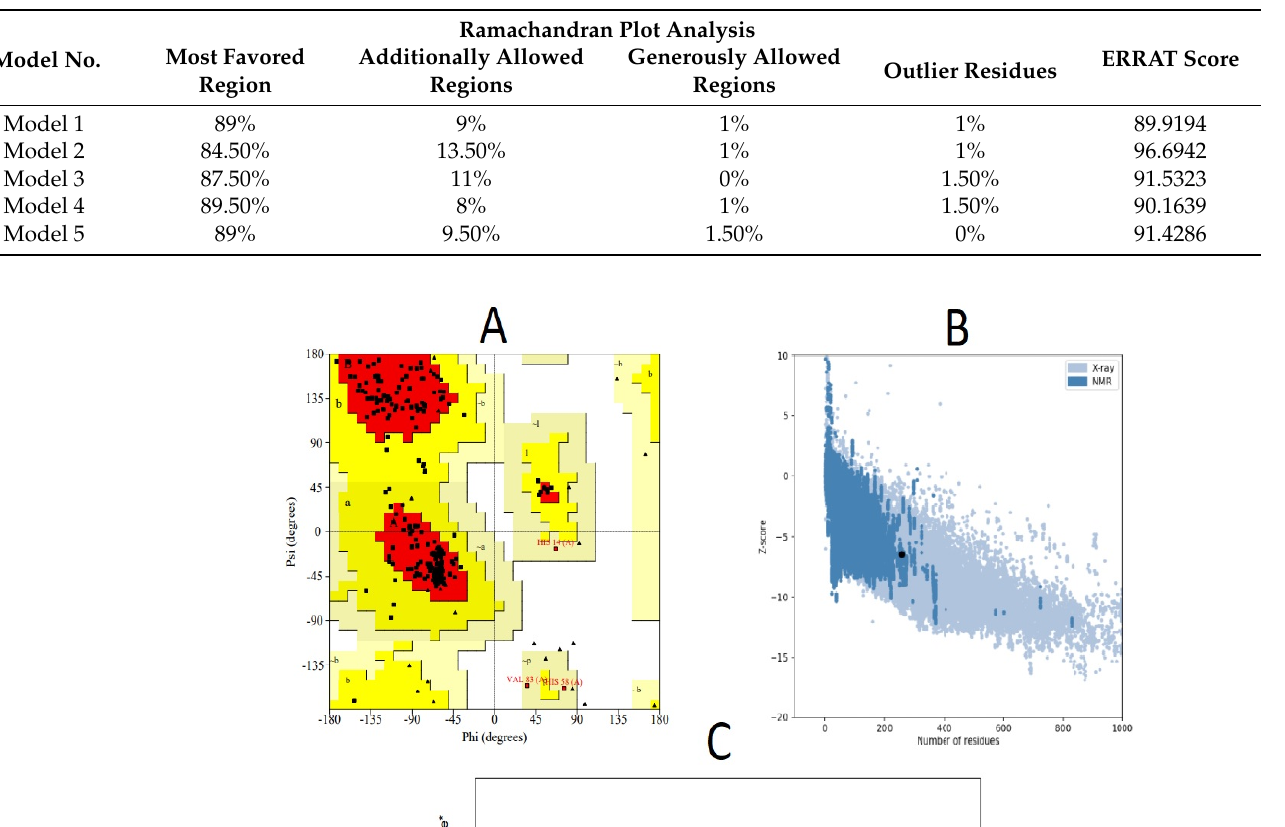
Table 3. Table showing structural features of models generated by the Robetta server.